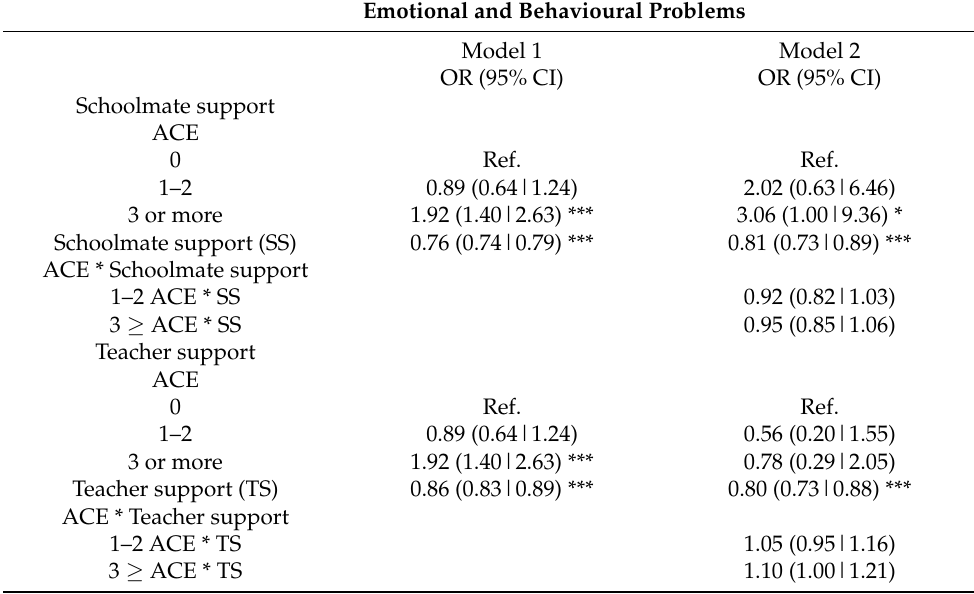
Table 2. The moderating effect of schoolmate and teacher support on the association between ACE with EBP adjusted for age, gender and FAS (Odds ratios and 95% confidence intervals) (Slovakia 2018, 11–15 years old, N =